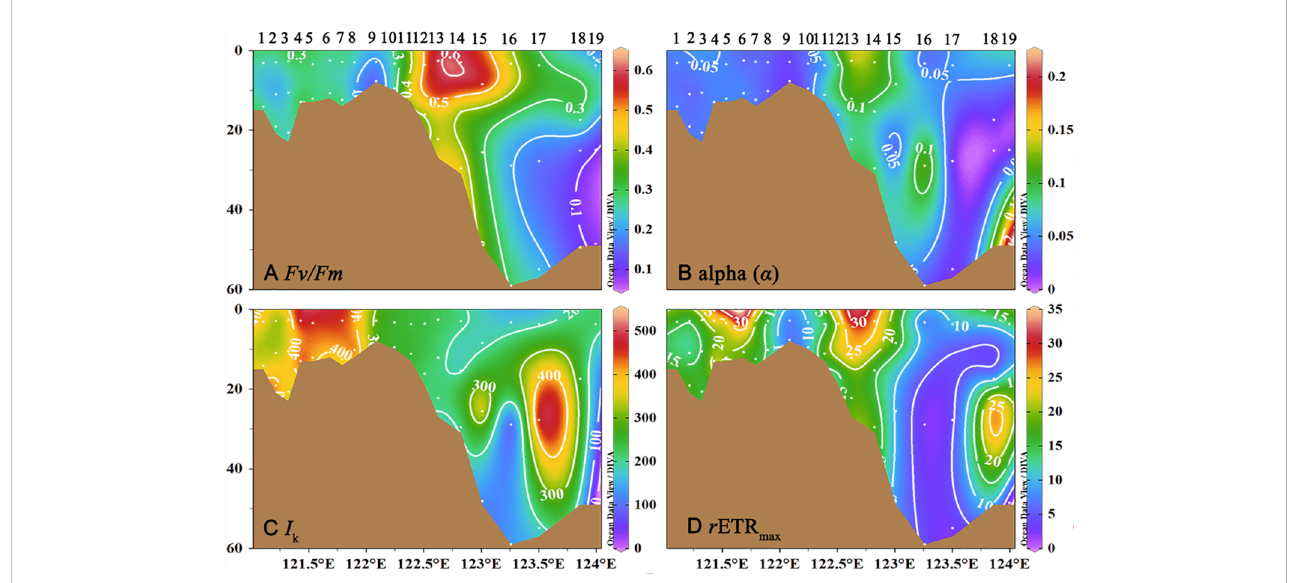
FIGURE 5 The vertical pro fi le of photosynthetic parameters at transect C in the southern branch of the Changjiang River Estuary and the East China Sea. (A) Fv/Fm ; (B) alpha ( a ); (C) I k ; (D) r ETR max